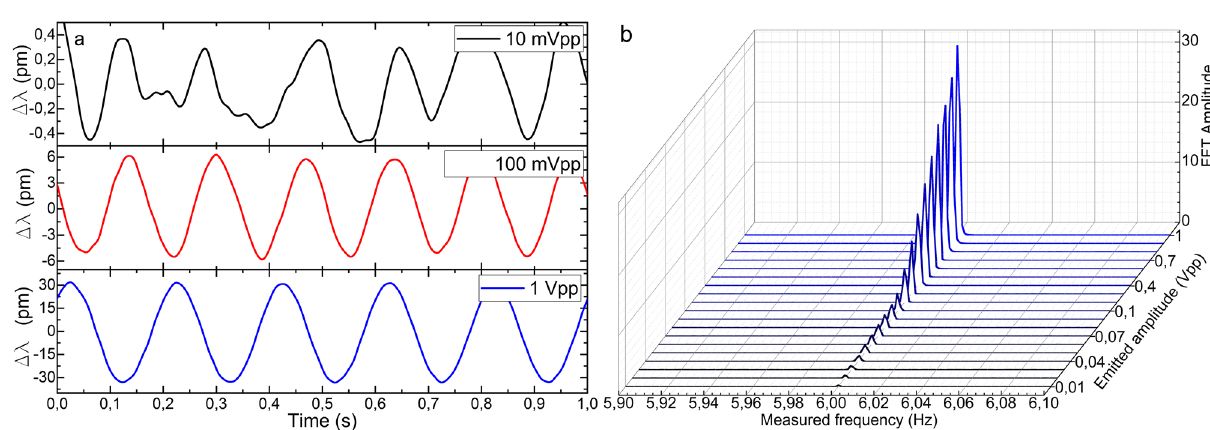
Figure 10. Results of the wavelength shift measurements in the manufactured optical device. ( a ) Time response of three representative cases, and ( b ) FFT amplitudes for sinusoidal signals of 6 Hz and amplitudes from 1 Vpp down to 10 mVpp.